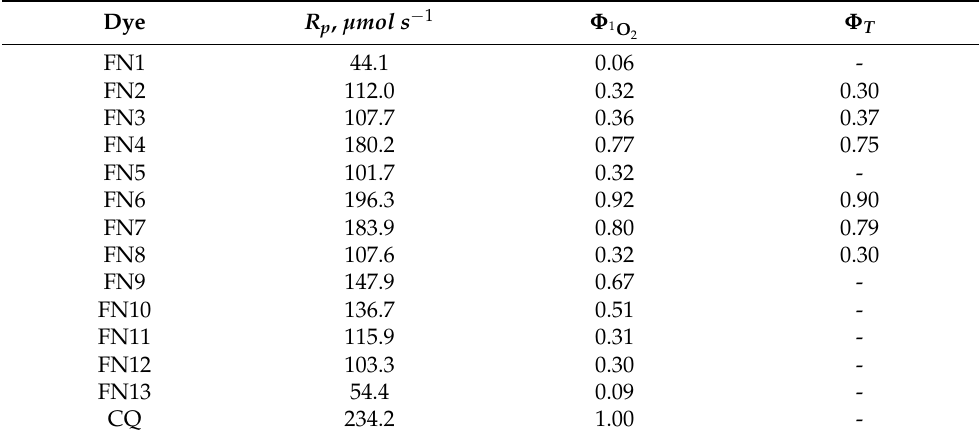
), quantum yield of the triplet state 2